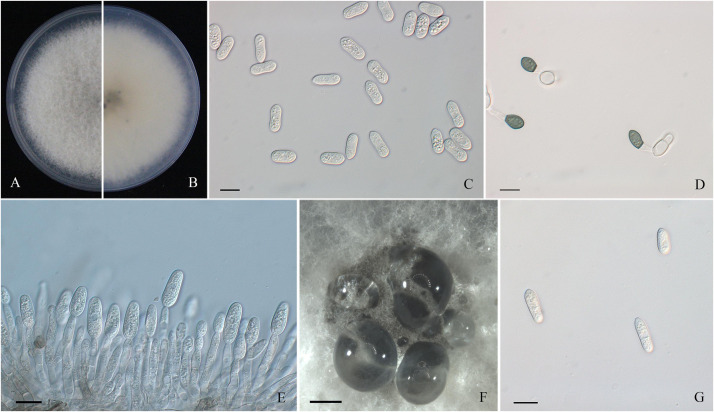
Morphological characters of Colletotrichum gloeosporioides sensu stricto. (A,B) Front and back view, respectively, of 6-days-old PDA culture. (C) Conidia. (D) Appressoria. (E) Conidiophores. (F) Ascomata developed on PDA plates. (G) Ascospores. Scale bars: (C–E,G) = 10 μm; (F) = 500 μm.